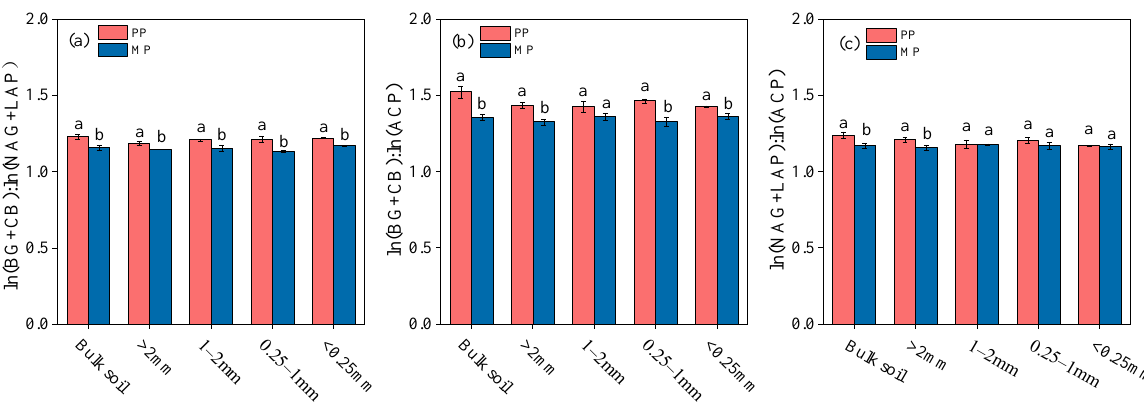
<0.25 mm aggregates (Figure 2c).